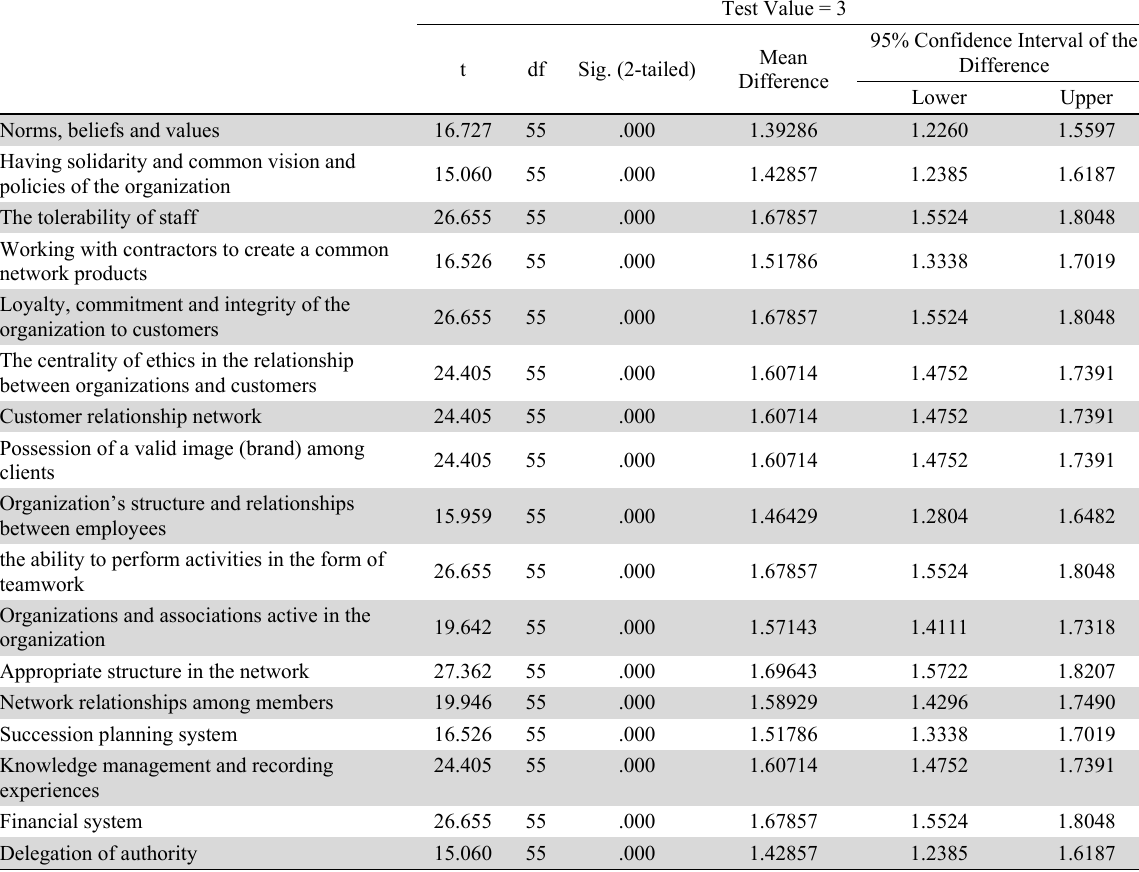
The results of testing the sub-factors influencing on lessons’ learned